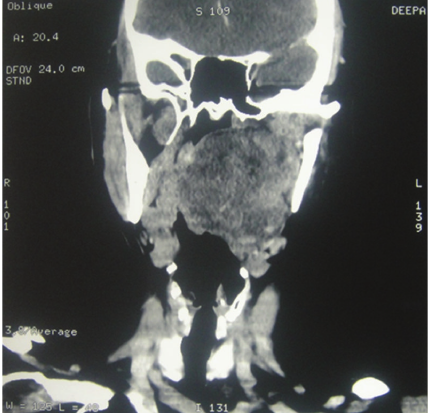
Figure 2: CECT coronal cut showing extent of mass.